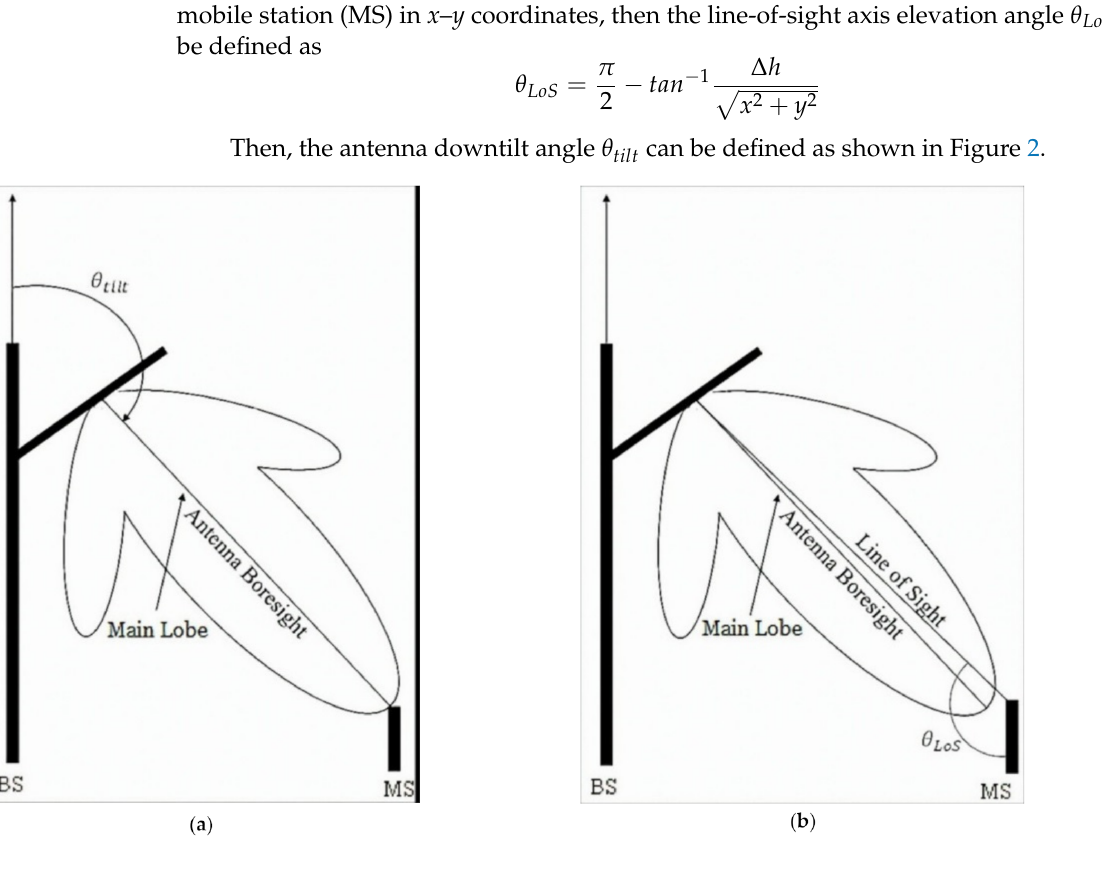
Figure 2. Definition of ( a ) θ tilt and ( b ) θ LoS